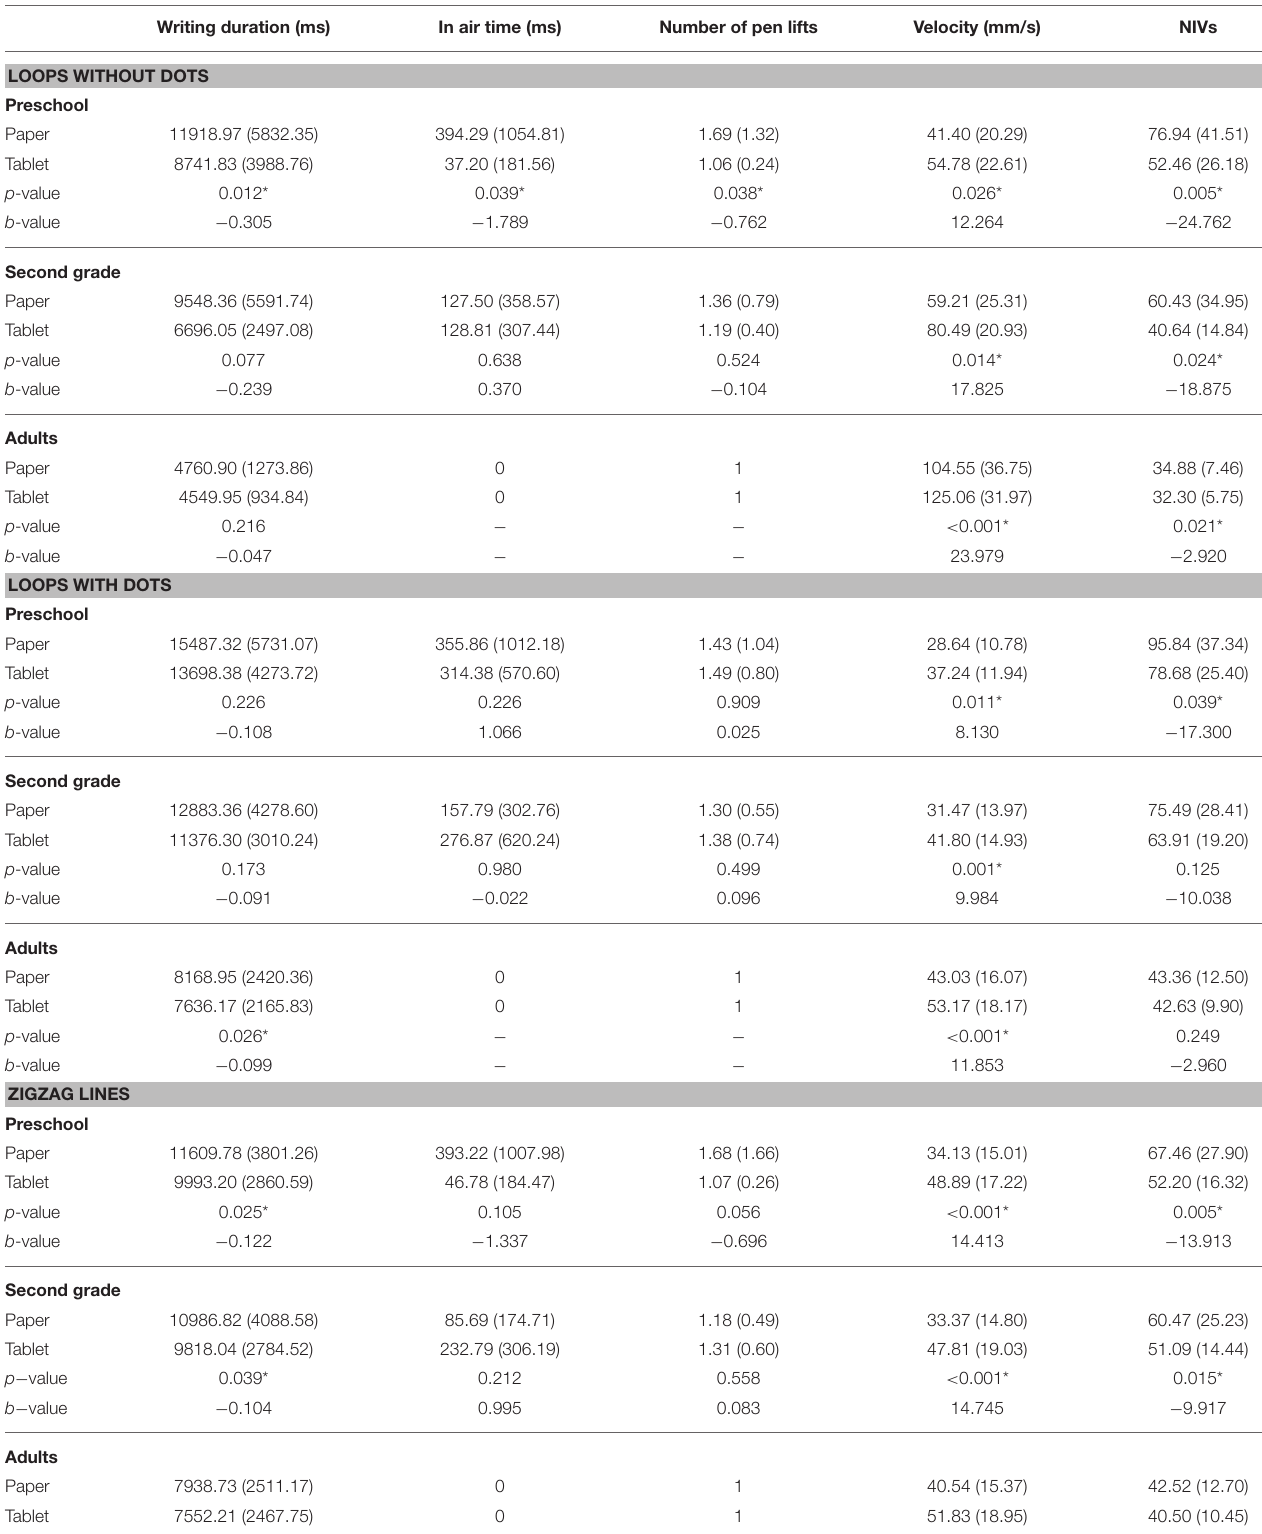
TABLE 2 | Means and standard deviations in parentheses for writing measures of the graphomotor